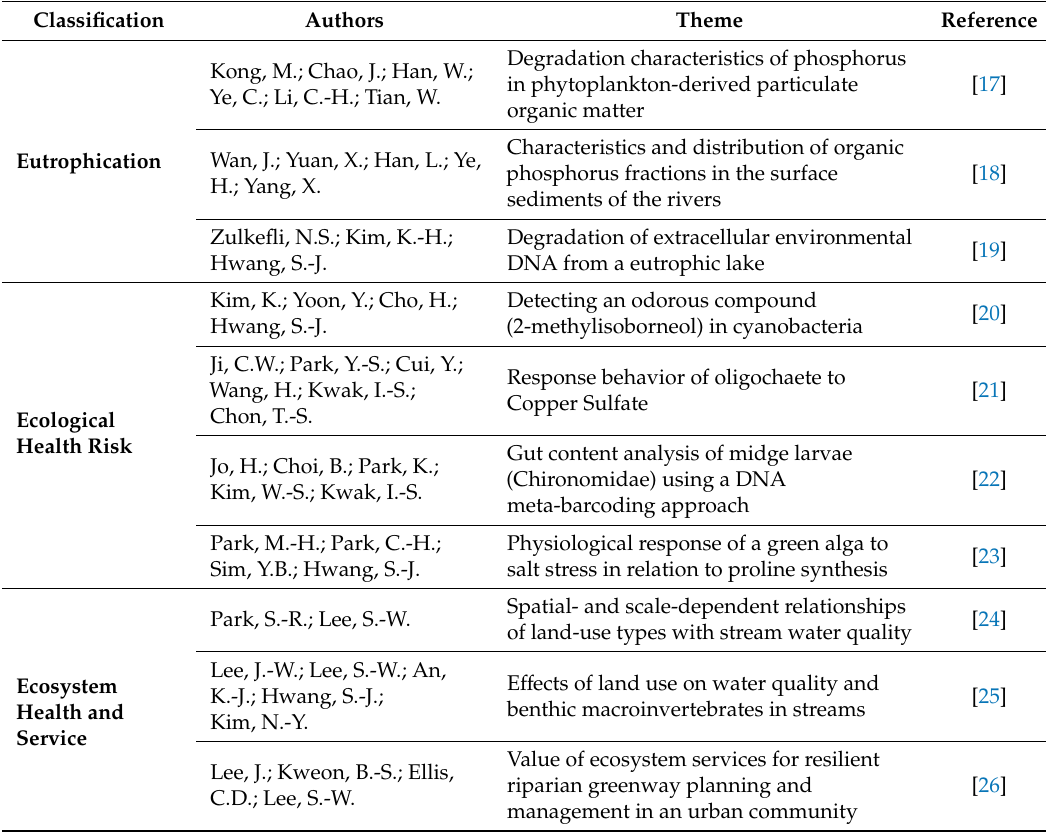
Table 1. Classification of selected articles published in the Special Issue, Eutrophication and the Ecological Health Risk, Environment Science and Engineering Section, IJERPH,